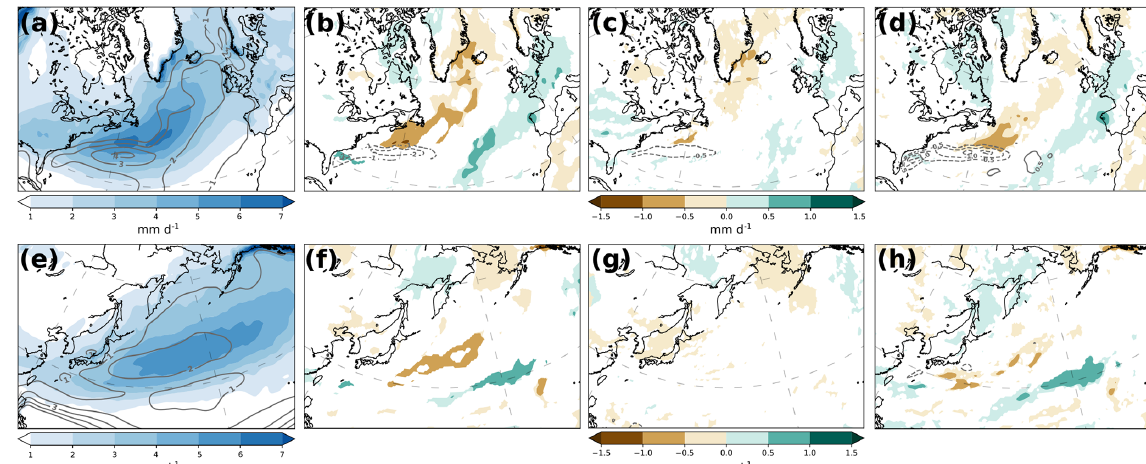
Figure 8. (a) Climatological large-scale precipitation (shading, mmd − 1 ) and convective precipitation (grey contours, interval: 1,mmd − 1 , zero contour omitted) for the North Atlantic for CNTL. (b) Statistically significant ( > 95%) difference of precipitation climatologies be- tween SMTHG and CNTL (SMTHG–CNTL) for large-scale (shading) and convective precipitation (grey contours, interval: 1,mmd − 1 , zero contour omitted). (c, d) As panel (b) but separated for large-scale and convective precipitation within (c) and outside (d) a radius of 750km around a cyclone centre. (e–h) As panels (a) – (d) but for the North